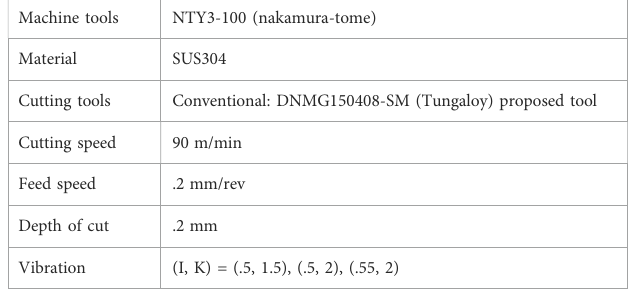
TABLE 1 Machining